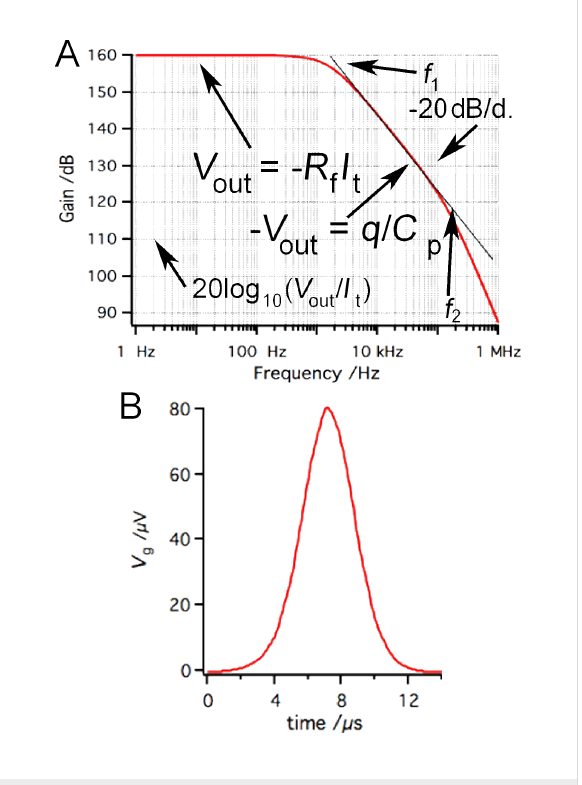
Figure 3: (A) Frequency response of the IVC presented in Figure 2. The following parameters were used to simulate R f = 100 M Ω , C p = 1 pF and C i = 10 pF. (B) The effect of the tunneling current presented in Figure 1 on the virtual